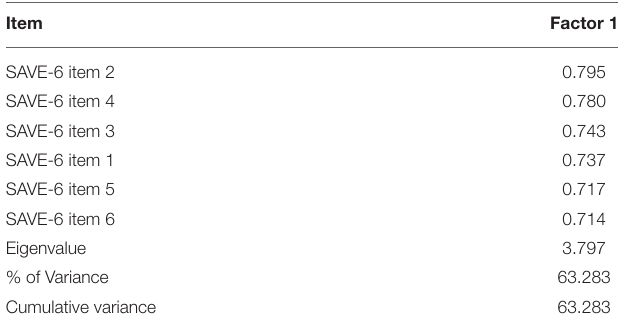
TABLE 2 | Results of exploratory factor analysis (EFA) of the SAVE-6 using principal component analysis with Oblimin rotation ( n =